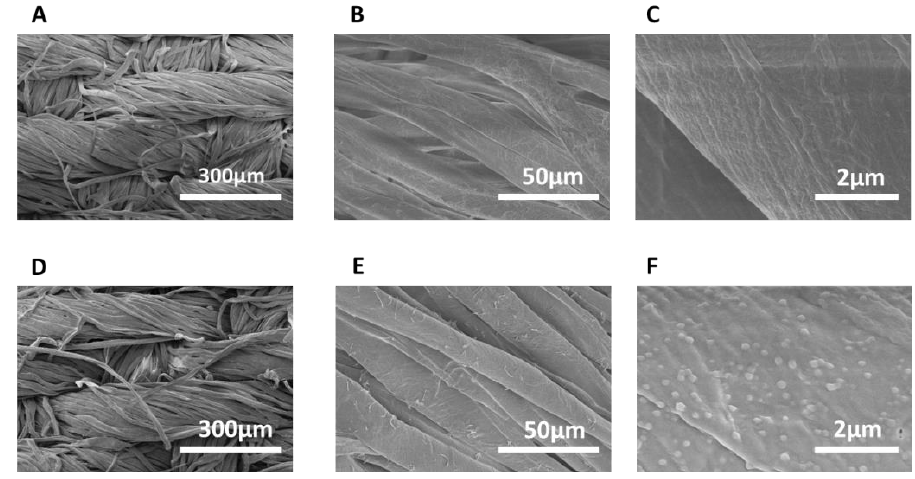
Figure 3 . FESEM images of ( A – C ) pristine ( D – F ) modified cotton fabric .